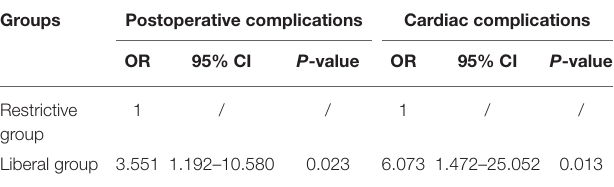
TABLE 3 | Effect of intraoperative total fluid infusion rate on postoperative outcomes.